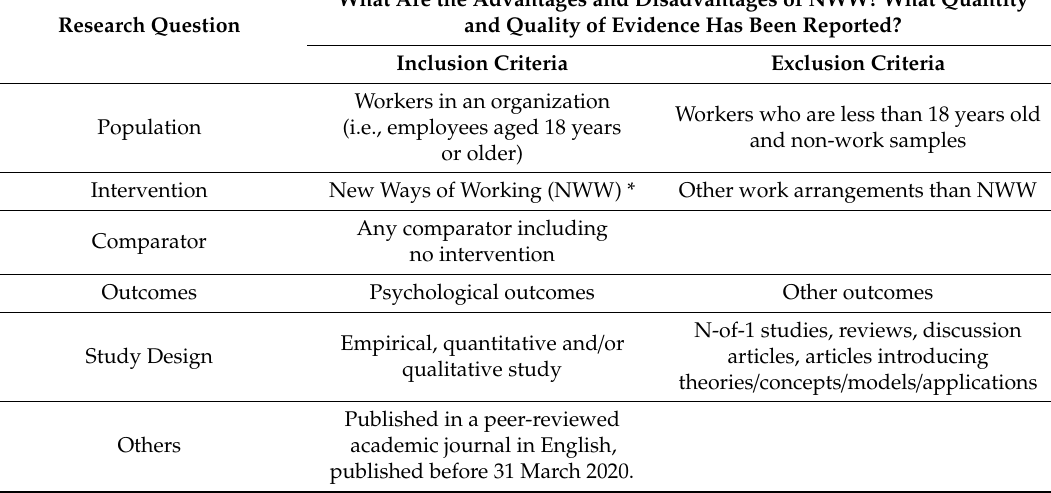
Table 1. Extended PICO (population, intervention, control and outcomes) for this review. What Are the Advantages and Disadvantages of NWW? What Quantity Research Question and Quality of Evidence Has Been